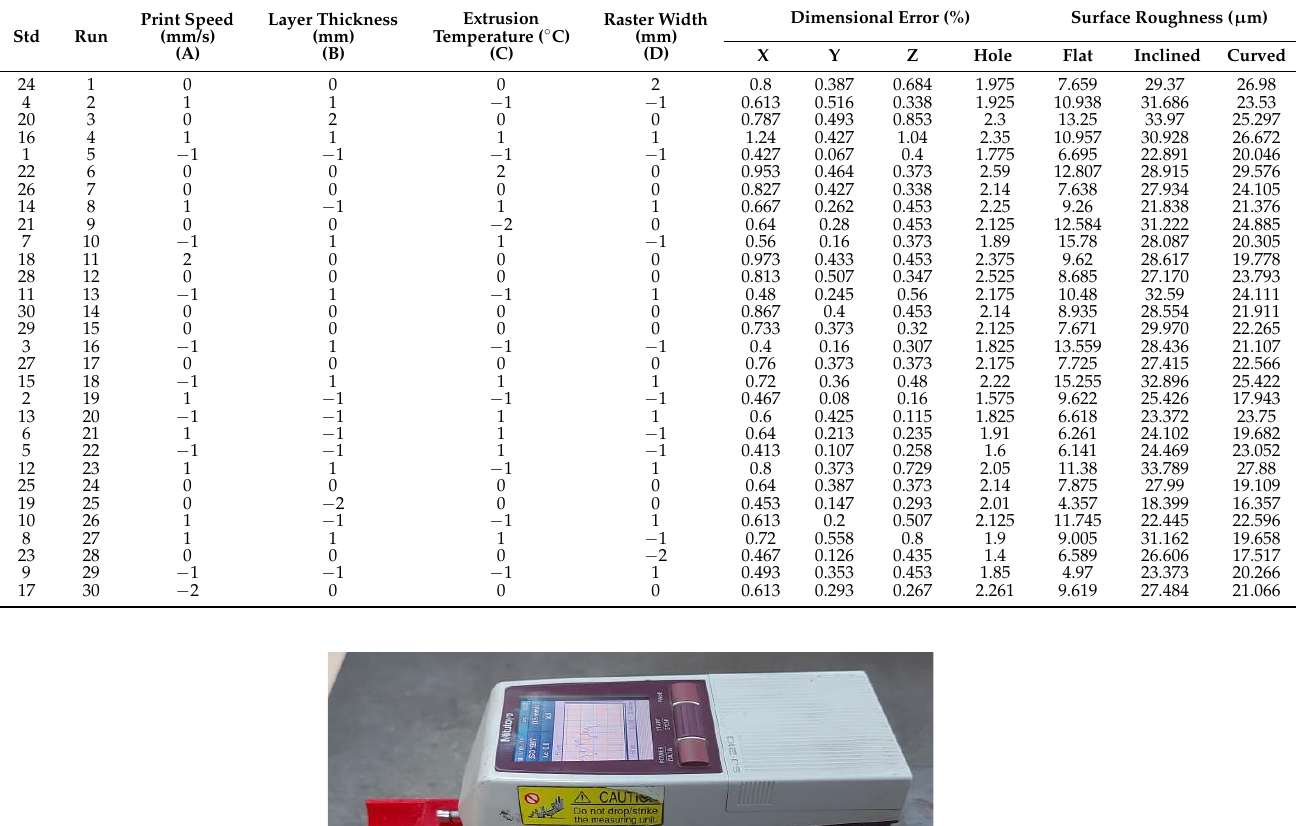
Table 2. Measured responses for dimensional accuracy for X, Y and Z axes and the hole geometry along with surface roughness responses for flat, inclined and curved surfaces.